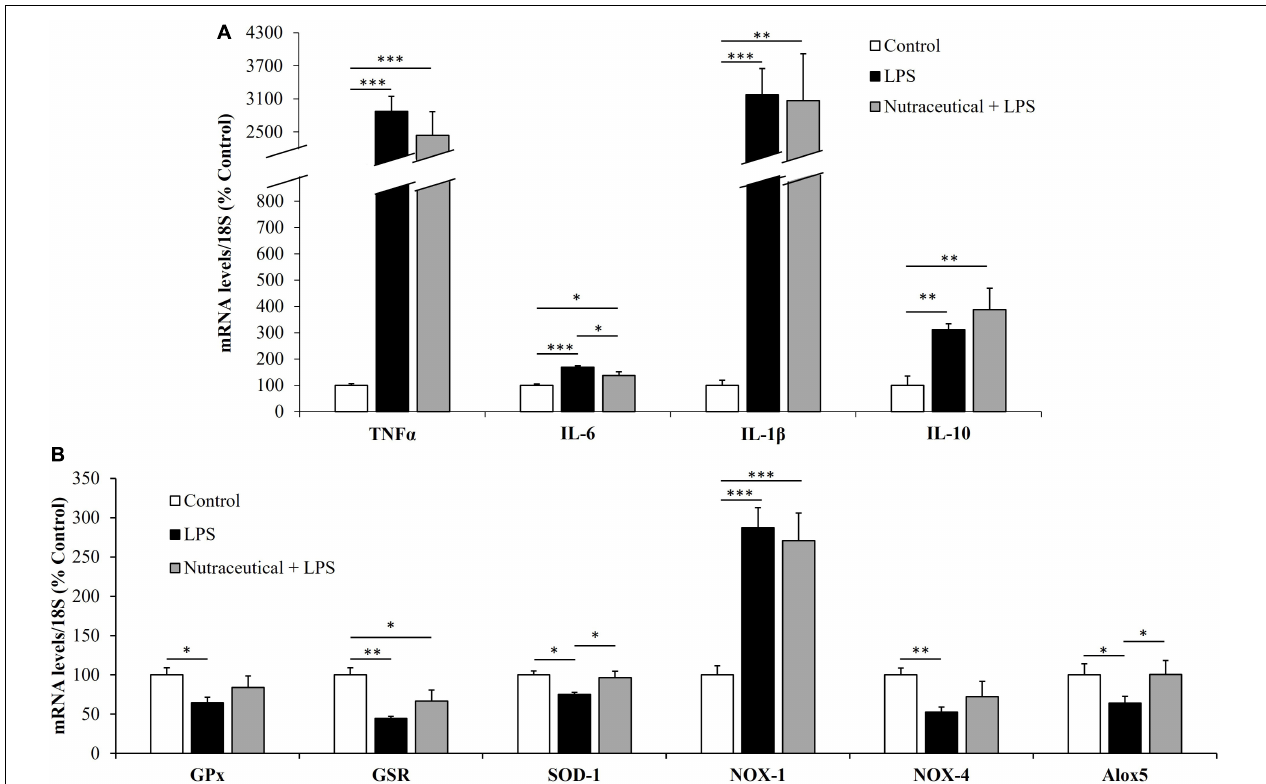
FIGURE 5 | mRNA concentrations of tumor necrosis factor α , Interleukin 6, Interleukin 1 β and Interleukin 10 (A) and Glutathione Peroxidase, Glutathione Reductase, Super Oxide Dismutase 1, NADPH oxidase 1 and 4, and Lipoxygenase (B) in the aorta of rats treated with vehicle, LPS or LPS + Nutraceutical. Values are represented as mean ± SEM. ∗ p < 0.05; ∗∗ p < 0.01; ∗∗∗ p <